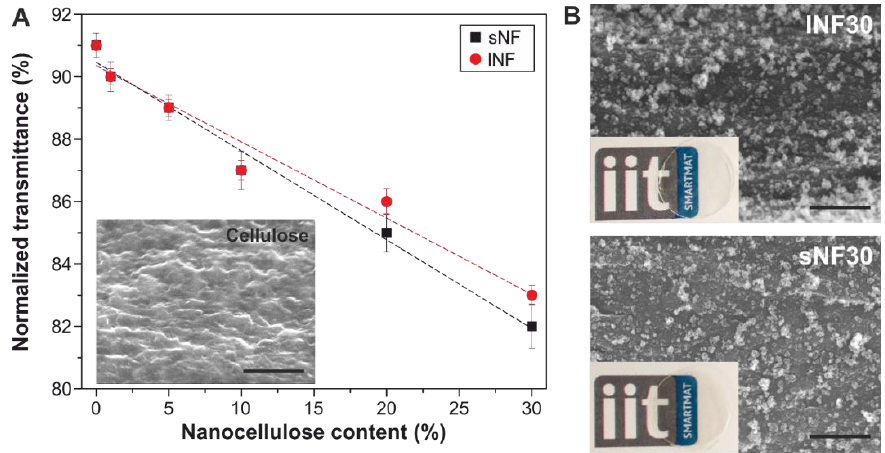
Figure 3. (A ) Normalized transmittance as a function of nanocellulose content. Inset: HR-SEM cross- section image of a cellulose sample. ( B ) HR-SEM cross-section images of lNF30 and sNF30 samples. Scale bar: 500 nm.